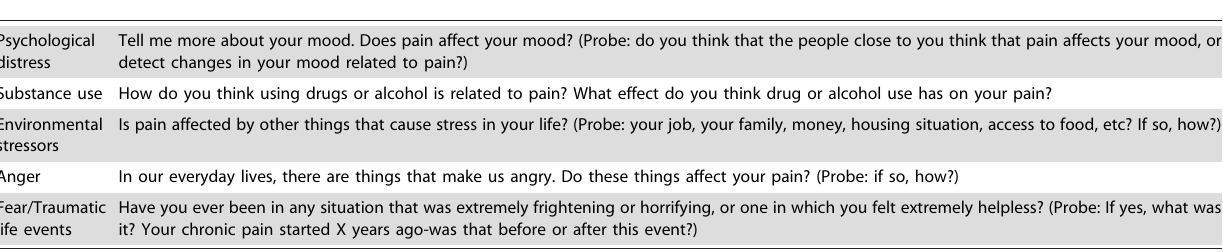
Table 1. In-Depth Interview Guide Psychological Probes.